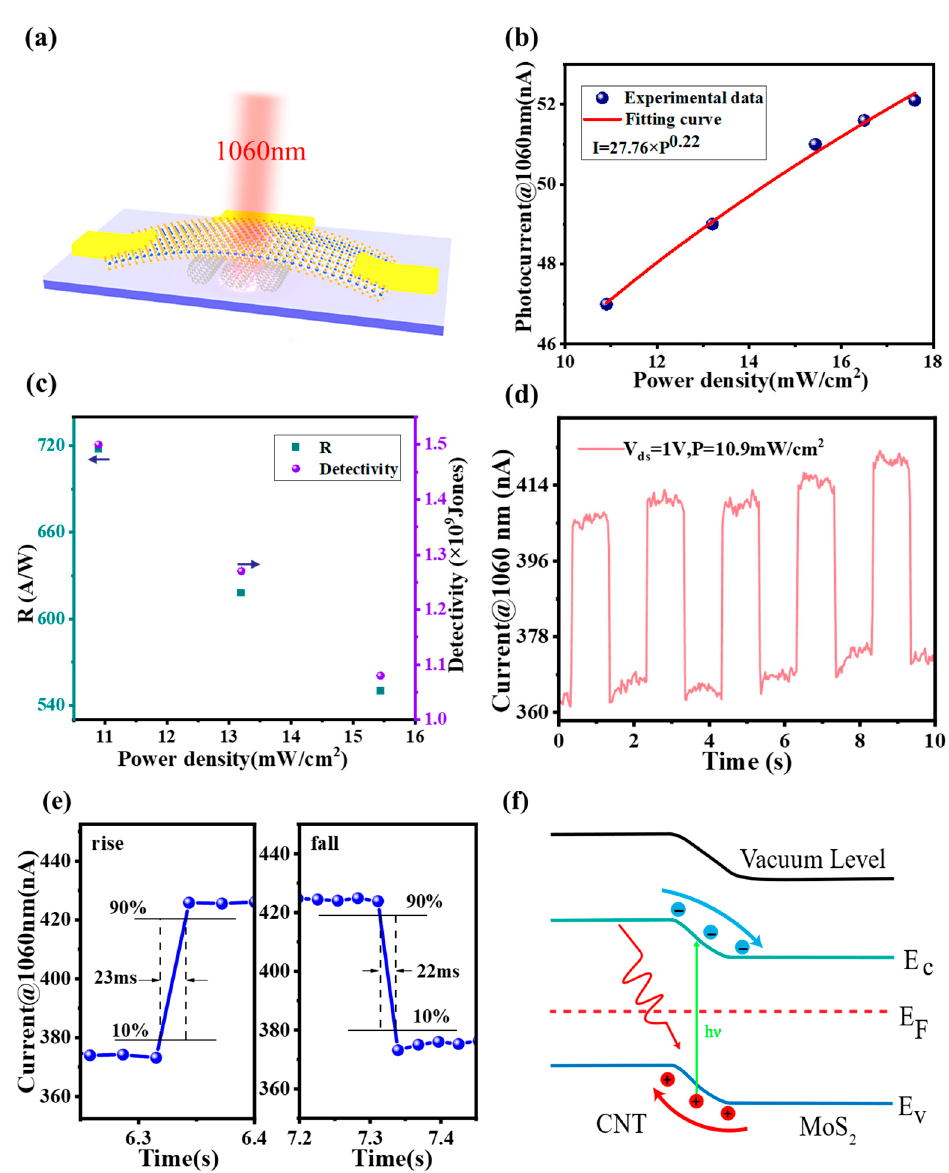
Figure 8. ( a ) Schematic illustration of the device under NIR (1060 nm) laser irradiation; ( b ) photocurrent vs. power density of the MWCNT-MoS 2 heterostructure photodetector device at V g = 0 V and V ds = 1 V; ( c ) variation in detection rate and responsiveness at different optical power densities; ( d ) variation in device response time at V ds = 1 V with an incident power of 10.9 mW/cm 2 illumination; ( e ) time-resolved photoresponse, where the rise and fall times of the photocurrent are approximately 23 ms and 22 ms, respectively; ( f ) energy band diagrams of CNT/MoS 2 vdW heterostructures in the light.